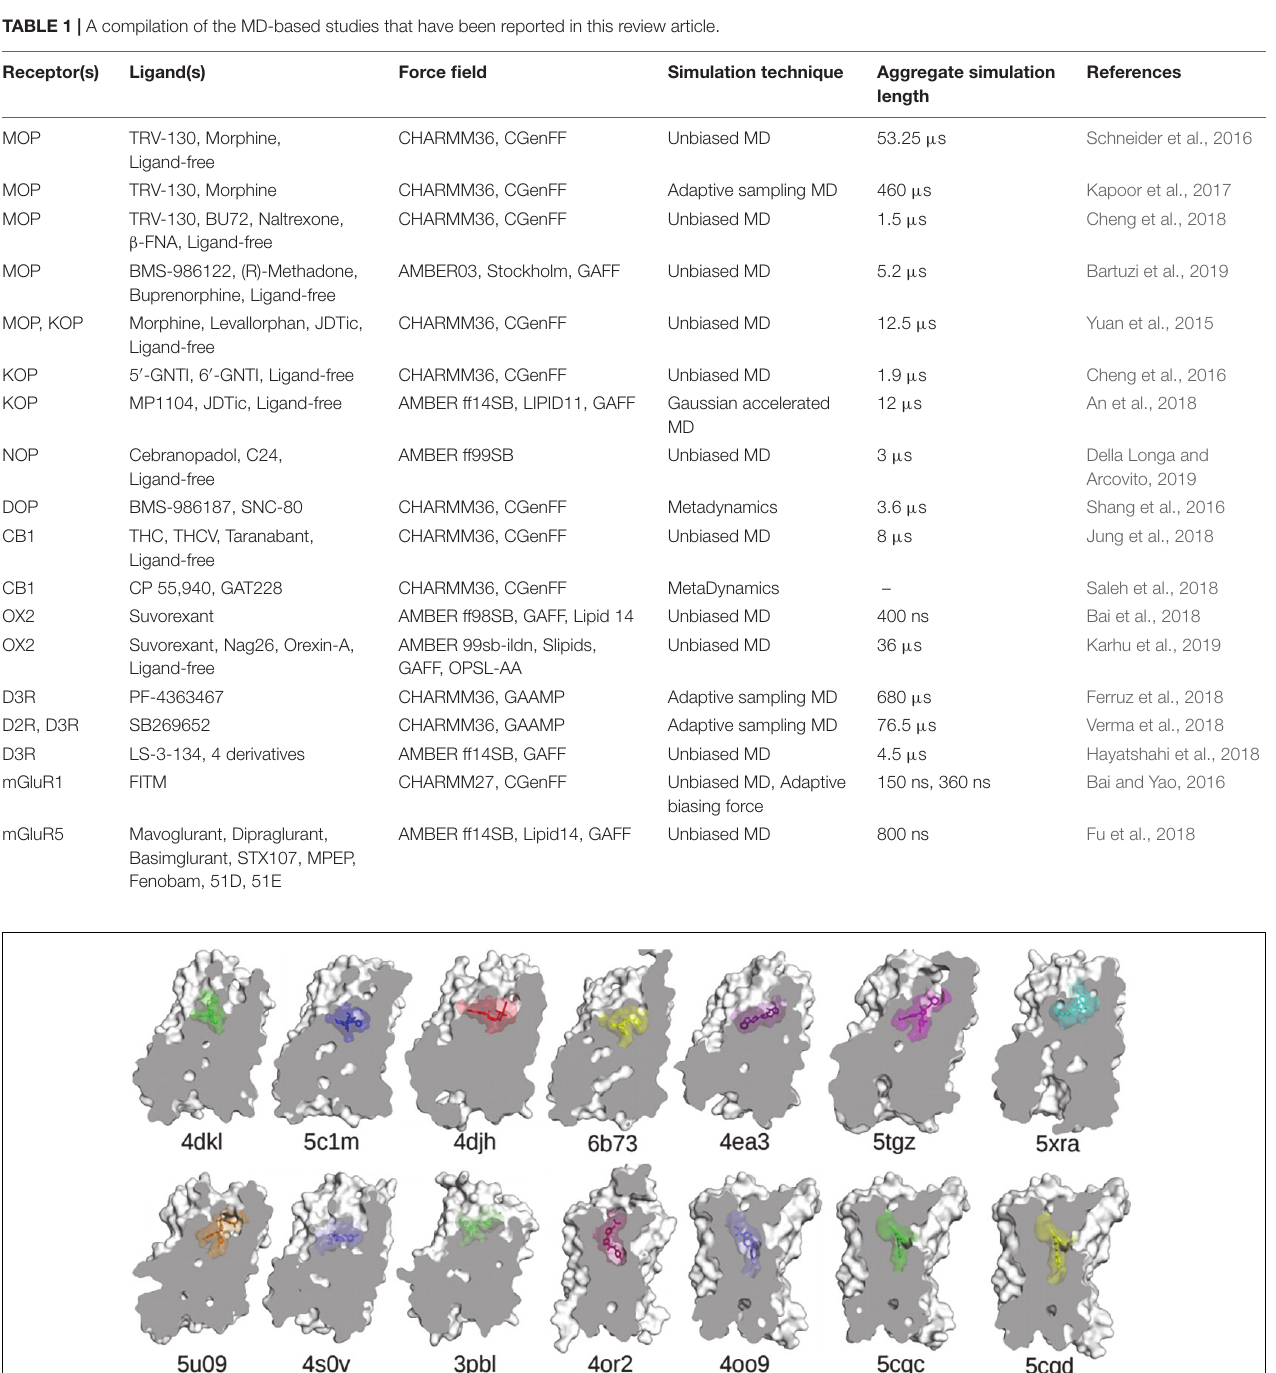
Frontiers in Molecular Neuroscience |